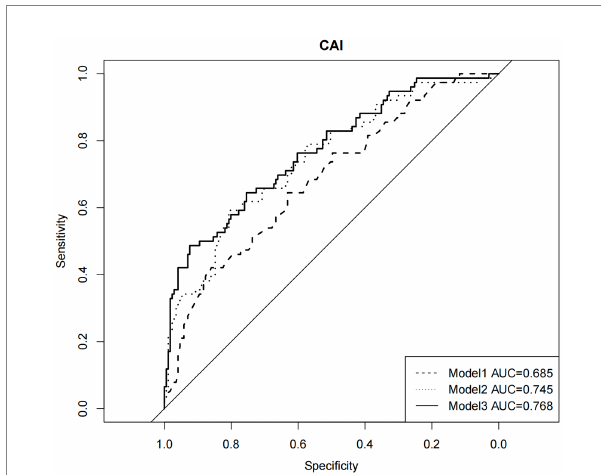
FIGURE 1 Receiver operator characteristic curve for demographic factors, HIV awareness variables, child sexual abuse in hierarchical logistic regression models predicting condomless anal intercourse ( N =247).